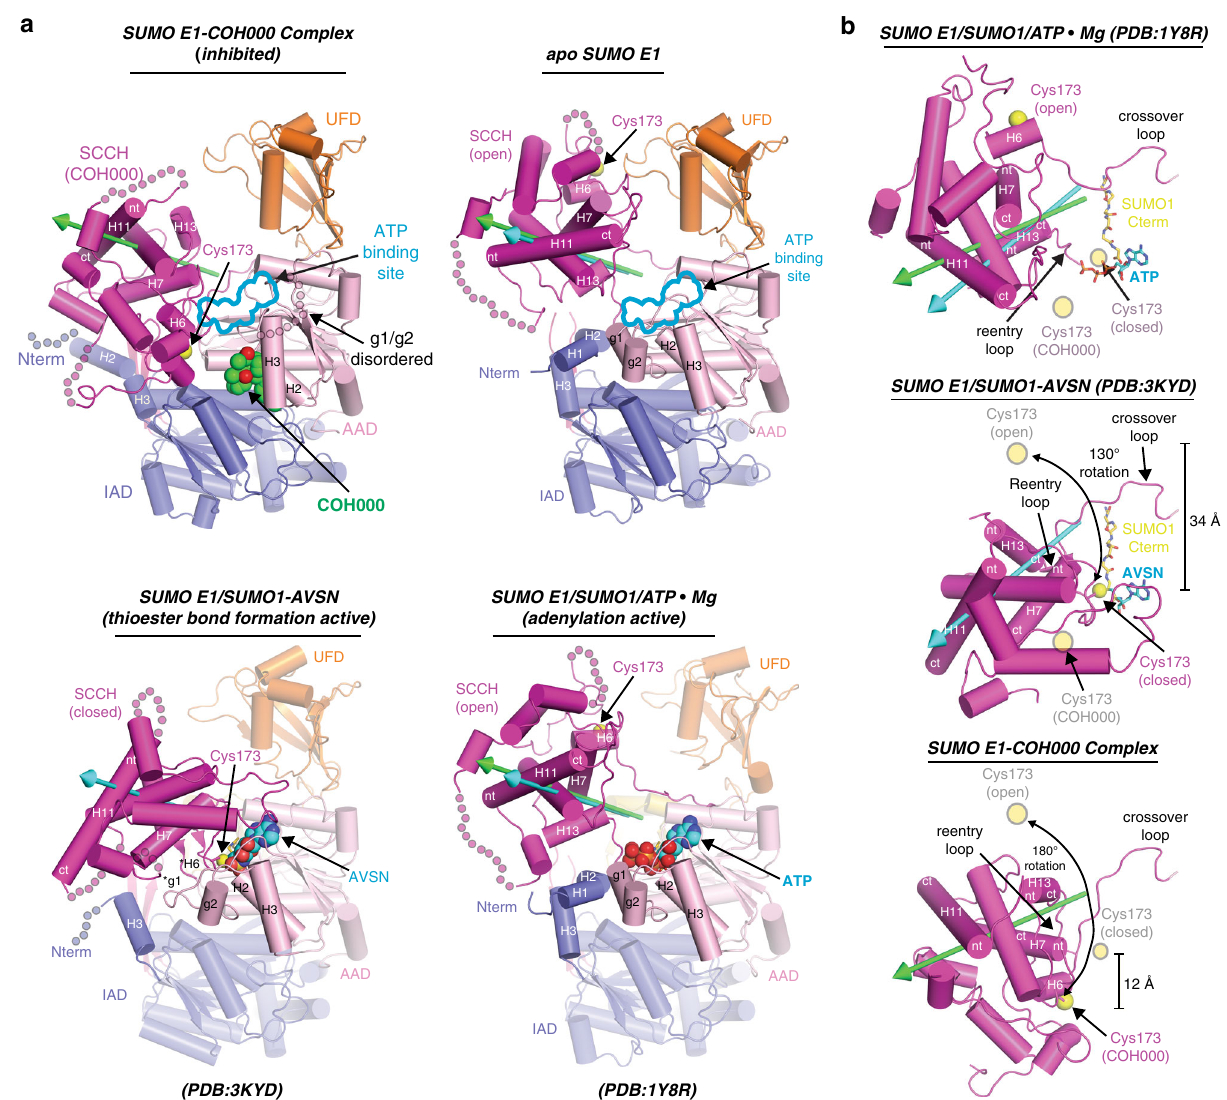
Fig. 1 Overall structure of SUMO E1 COH000 and comparison to other SUMO E1 conformational snapshots. a Comparison of the SUMO E1 COH000 , SUMO E1 APO , SUMO E1/SUMO1/ATP (cid:129) Mg (PDB: 1Y8R), and SUMO E1/SUMO1-AVSN (PDB: 3KYD) structures, shown as cartoon representations. The green and cyan arrows highlight the rotation axes during transition of the SCCH domain from open to COH000-inhibited and open to closed conformations, respectively. AVSN is an adenosine analog harboring an electrophilic vinyl sulfonamide that was used to covalently trap the tetrahedral intermediate generated during SUMO E1 – SUMO thioester bond formation 27,39 . Asterisks indicate helices that undergo structural remodeling in the thioester bond formation active structure. SUMO E1 domains are labeled and color-coded. COH000, ATP, AVSN, and the SUMO E1 catalytic cysteine are shown as spheres. Selected helices of the SCCH domain are labeled and their N and C termini are indicated by ‘ nt ’ and ‘ ct ’ , respectively. The ATP-binding sites of the SUMO E1 COH000 and SUMO E1 APO structures are indicated with a cyan outline. Regions of disorder are indicated with semitransparent circles. b Comparison of SUMO E1 SCCH domain in the open (adenylation active), closed (thioester bond formation active), and COH000 (inhibited) conformations. The adenylation domains (which serve as the rigid body of SUMO E1) were superimposed and the SCCH domains are shown as cartoons with the catalytic cysteines shown as spheres. SCCH domain alternations are highlighted by double-headed arrows and the degree of rotation between each conformational state (with reference to the open conformation) is indicated. Rotation axes of the SCCH domains are highlighted as in a . To provide a frame of reference, the relative position of the catalytic cysteine in the other SCCH domain conformational states are indicated with semitransparent yellow circles and labeled accordingly in each of the